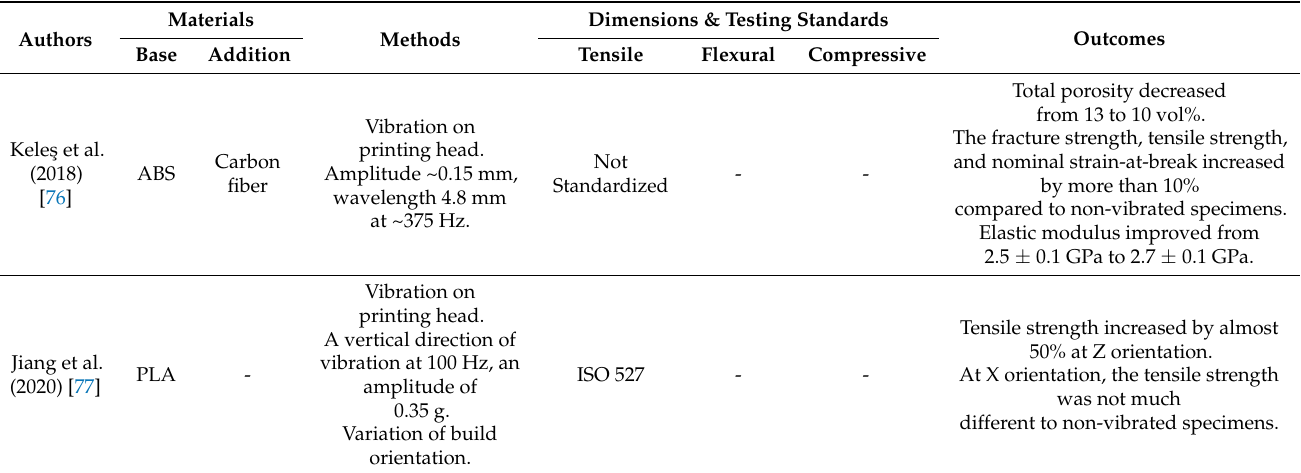
Table 5. Research on Vibration-Assisted FFF.